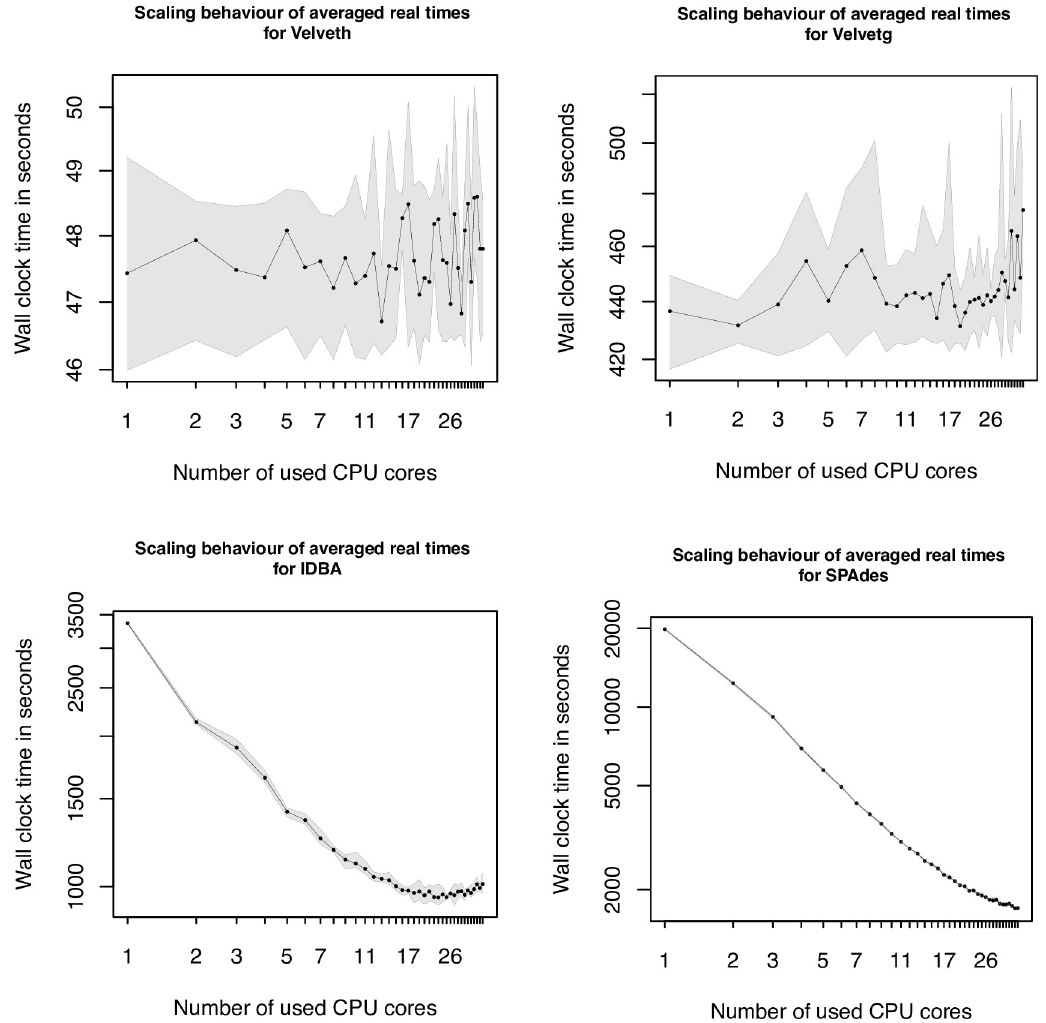
Fig 4. Scaling plots 5—8. Graphs, showing the scaling behavior of Velveth (top left), Velvetg (top right), IDBA-UD (bottom left) and SPAdes (bottom right) of the long dataset. The x-axes represent the number of used cores in the range of 1 to 36. The y-axes show averaged wall-time values in seconds, in different ranges, depending on the tool. Both axes are scaled logarithmic to make a linear behavior visible. In addition to the scaling graph, the minimal and maximal values of the five conducted runs are illustrated by the borders of the area in